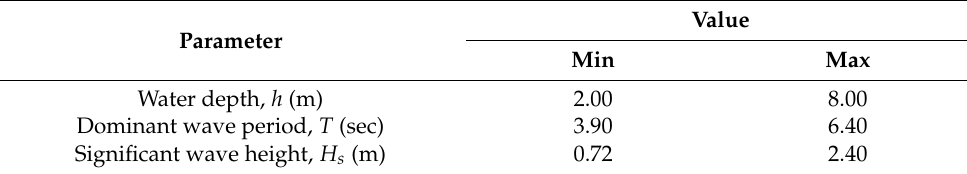
Table 1. Hydrodynamic characteristics of a prototype in South Florida.